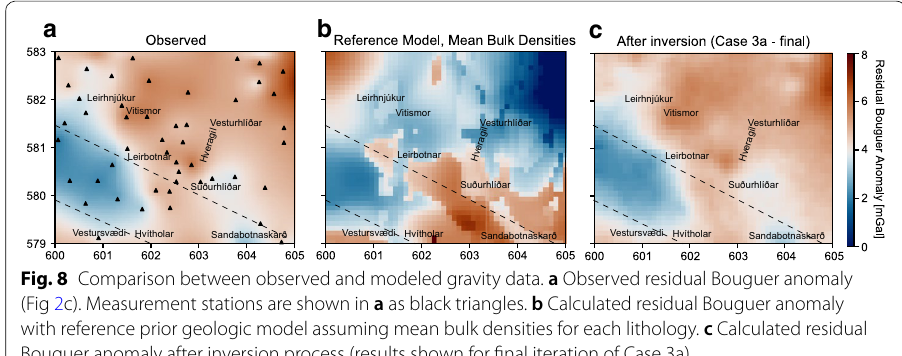
Fig. 8 Comparison between observed and modeled gravity data. a Observed residual Bouguer anomaly (Fig 2c). Measurement stations are shown in a as black triangles. b Calculated residual Bouguer anomaly with reference prior geologic model assuming mean bulk densities for each lithology. c Calculated residual Bouguer anomaly after inversion process (results shown for final iteration of Case